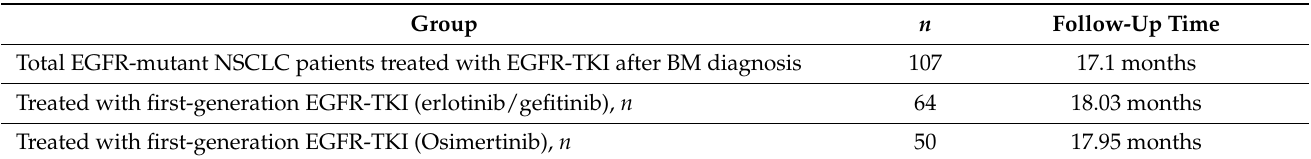
Table 1. Number of patients with EGFR-mutant NSCLC patients with brain metastases who received EGFR-TKI after BM diagnosis.